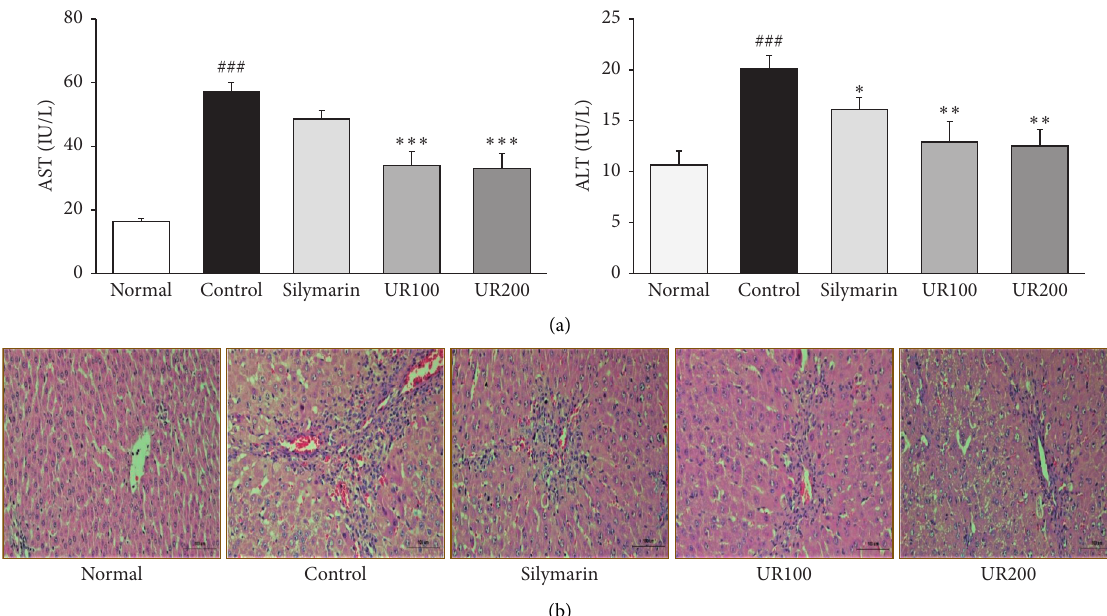
Figure 2: Effect of UR on serum liver function and histological alterations. (a) Effects of UR on serum levels of AST and ALT in rats. (b) Histological alterations in the liver. Liver tissue sections were stained with hematoxylin and eosin. Scale bar � 100 μ m (magnification, × 200). Data are expressed as the mean ± SEM ( n � 7). Significance: #### p < 0 . 001 vs. the normal group and ∗ p < 0 . 05, ∗∗ p < 0 . 01, and ∗∗∗ p < 0 . 001 vs. the ALI control group.